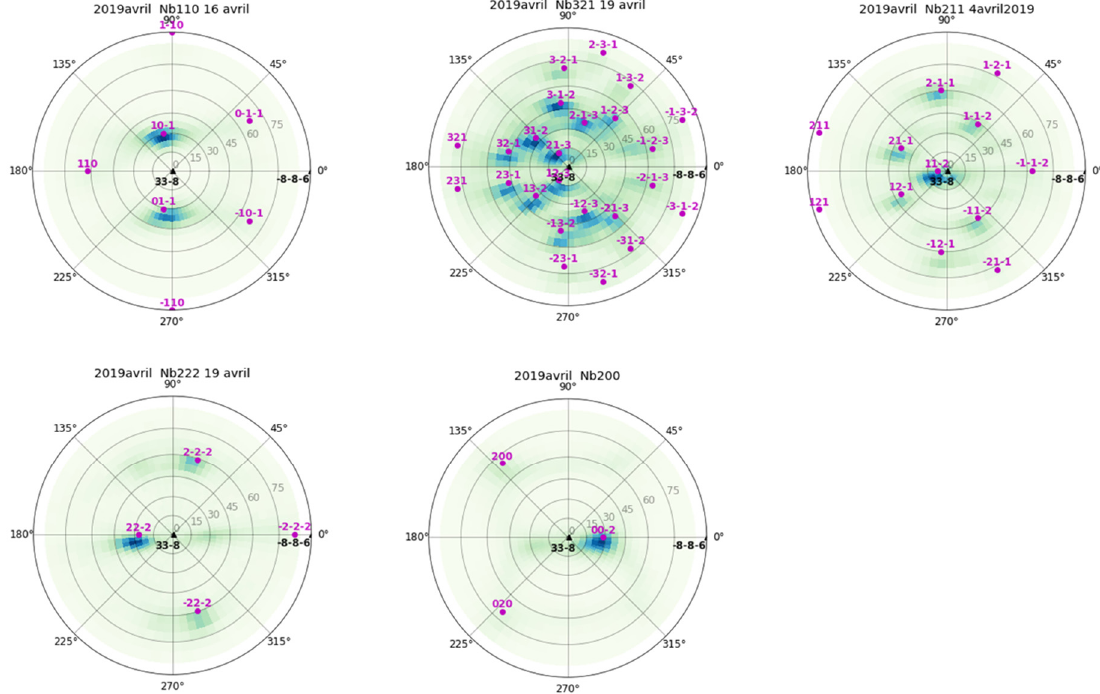
Figure 2. Pole figure measurements of niobium in Cu(16)/Nb(16) ARB nanolaminate using a 4-axis diffractometer [57].